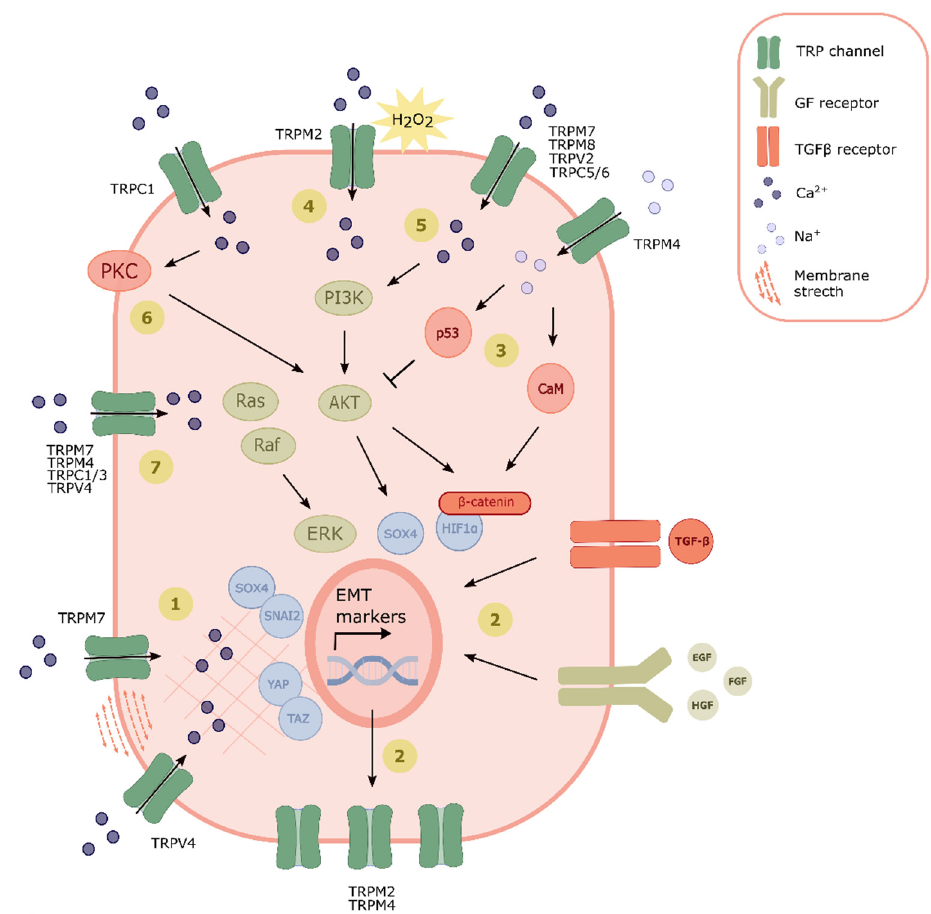
Figure 2. TRP channel signaling in EMT: (1) Membrane stretching caused by extracellular stimuli or cytoskeletal alterations induces TRP channel activation and promotes SOX4/SNAI2 and/or YAP/TAZ signaling. (2) TGFB and GF bind to their respective receptors and induce EMT, thereby upregulating TRP channel expression. (3) Entry of Na + via TRPM4 promotes p53, thereby preventing EMT induction via inhibiting AKT signaling. Alternatively, calmodulin (CaM) activation via TRPM4 activity leads to β -catenin/HIF-1 α stabilization and EMT induction. (4) ROS-induced TRP channel activation promotes PI3K/AKT pathway signaling, promoting EMT induction. (5) Other TRP channels promoting EMT via the PI3K/AKT pathway are TRPM7, TRPM8, TRPV2, TRPC5 and TRPC6. (6) Activation of PKC and AKT via TRP channel mediated Ca 2+ entry (7) Activation of the Ras/Raf/ERK pathway via TRP channel signaling promotes EMT